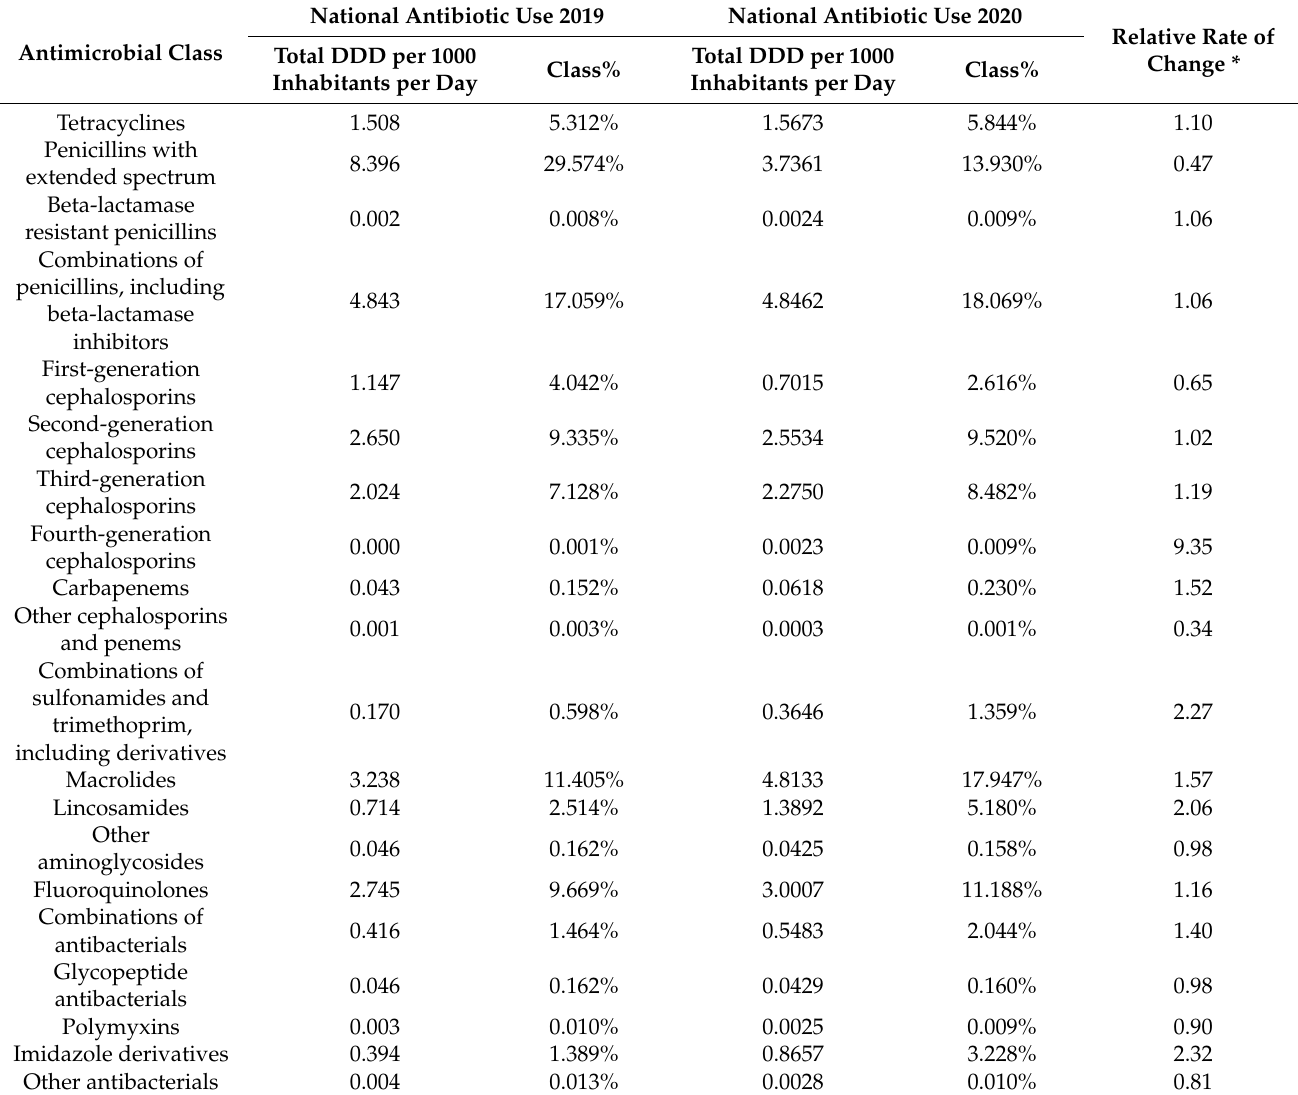
Table 1. National antimicrobial consumption, expressed in DDD per 1000 inhabitants per day per antimicrobial class, for